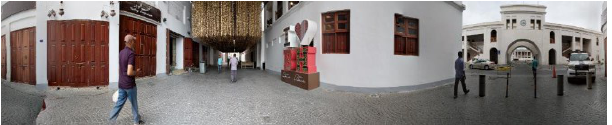
Figure 9: Anagrammatic view for the Bab Al Bahrain (zone a the main gate) and main approach of the avenue (zone b in “I love Bahrain”